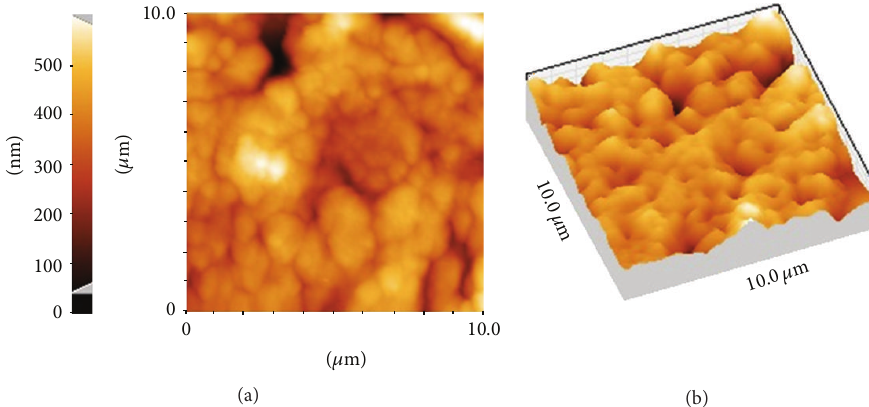
Figure 8: AFM micrographs (a) 2D and (b) 3D of the surface morphology of the colloidal titania-coated alumina substrate.